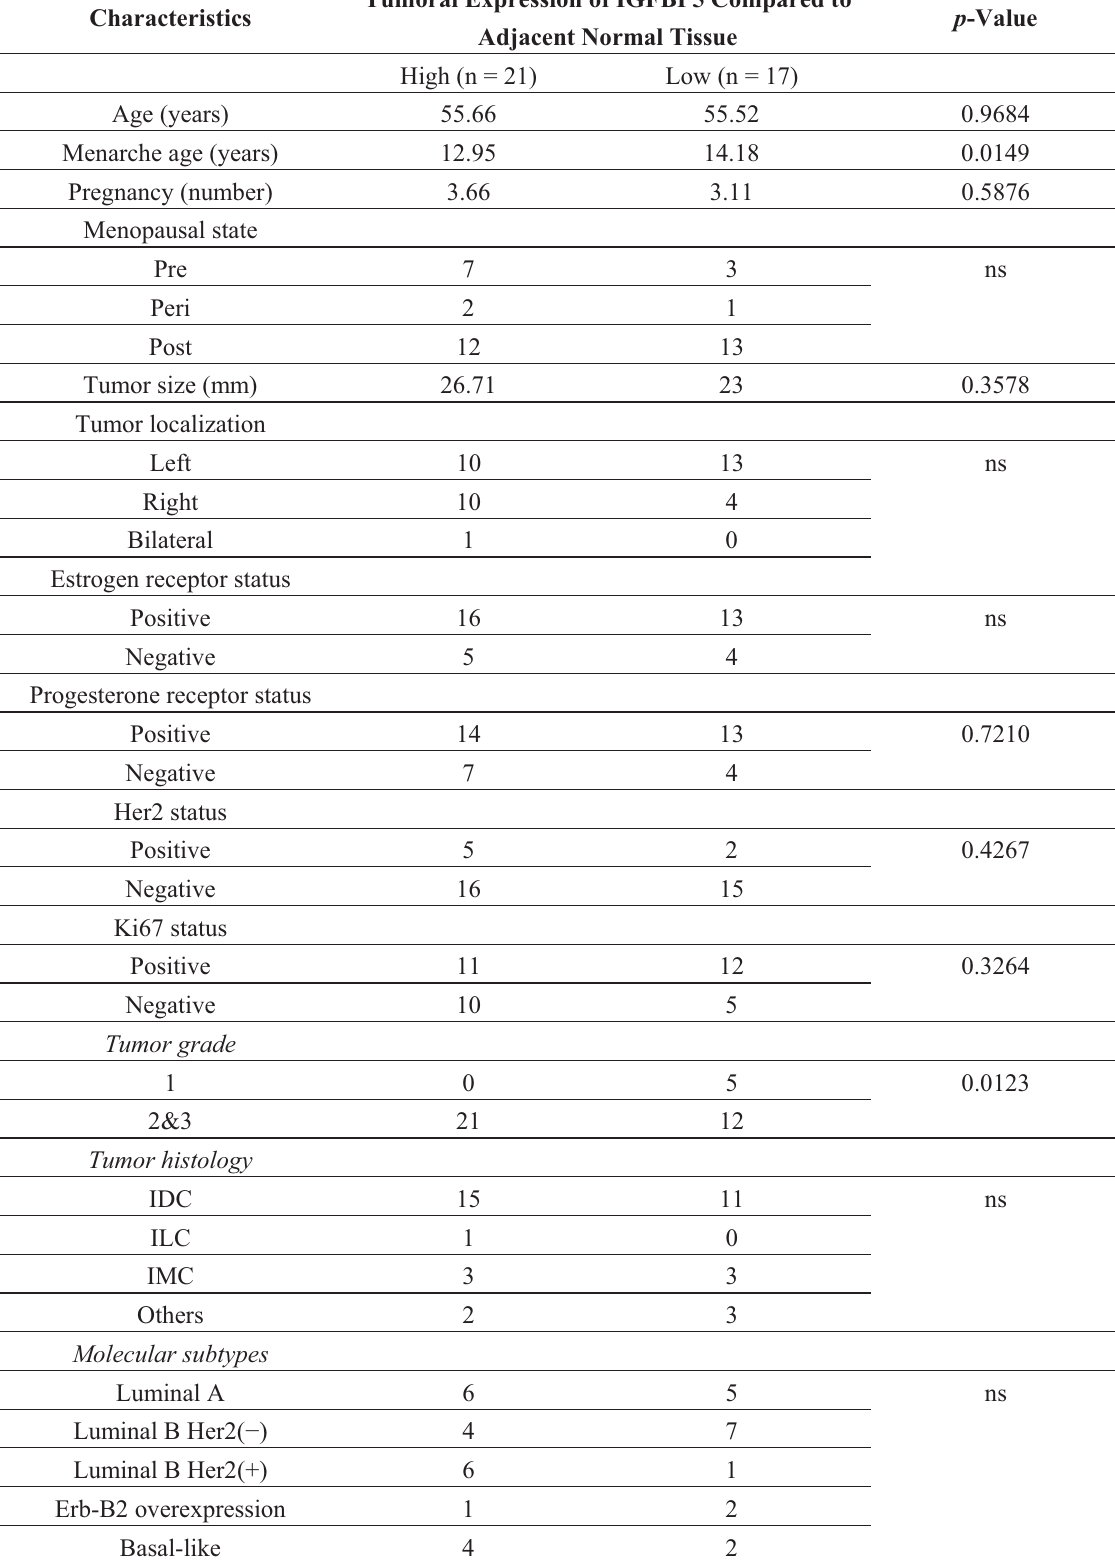
Table 1. Differences of clinicopathological parameters depending on tumoral expression of IGFBP5 compared to adjacent normal